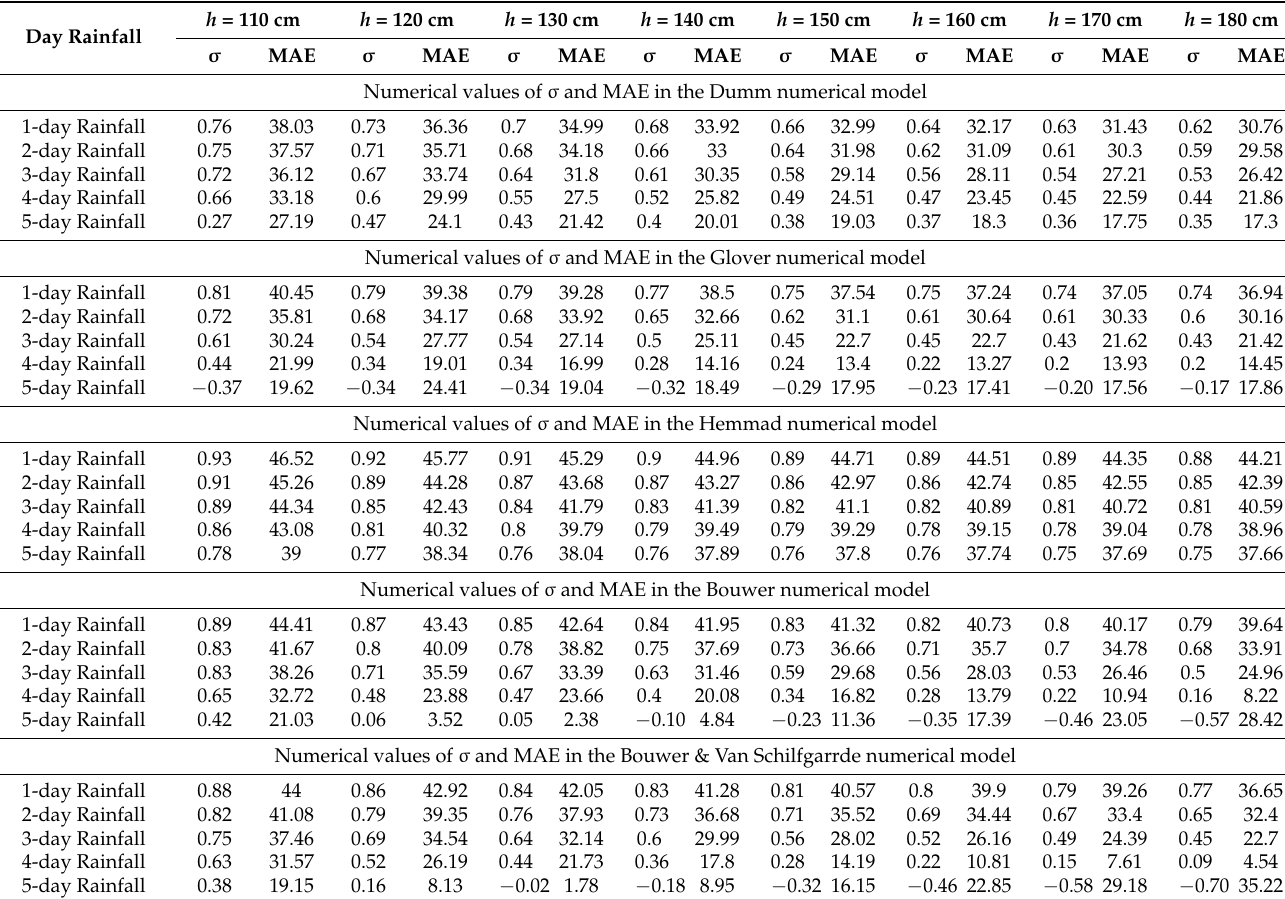
Table 5. Mean numerical percentage ( σ ) and (MAE) under the numerical model of unsteady condi- tions and daily rainfall in the depth of drain ( h ) of 110 cm; 180